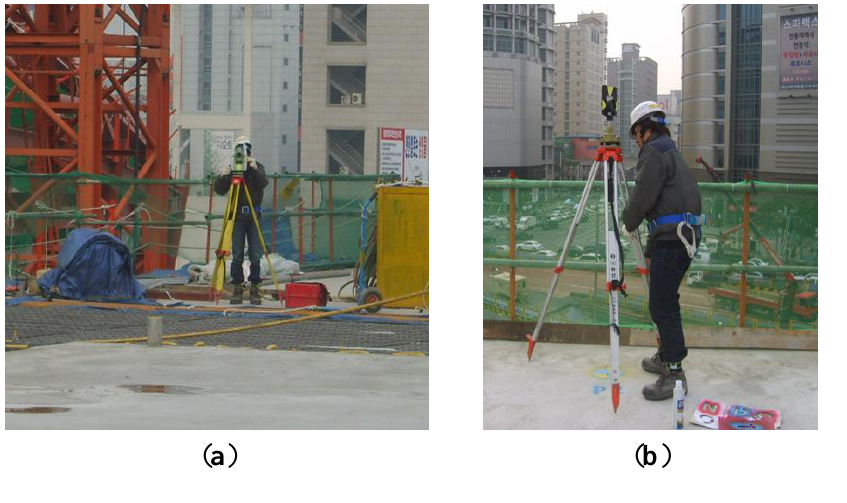
Figure 10. Total station measurement: ( a ) total station and ( b )